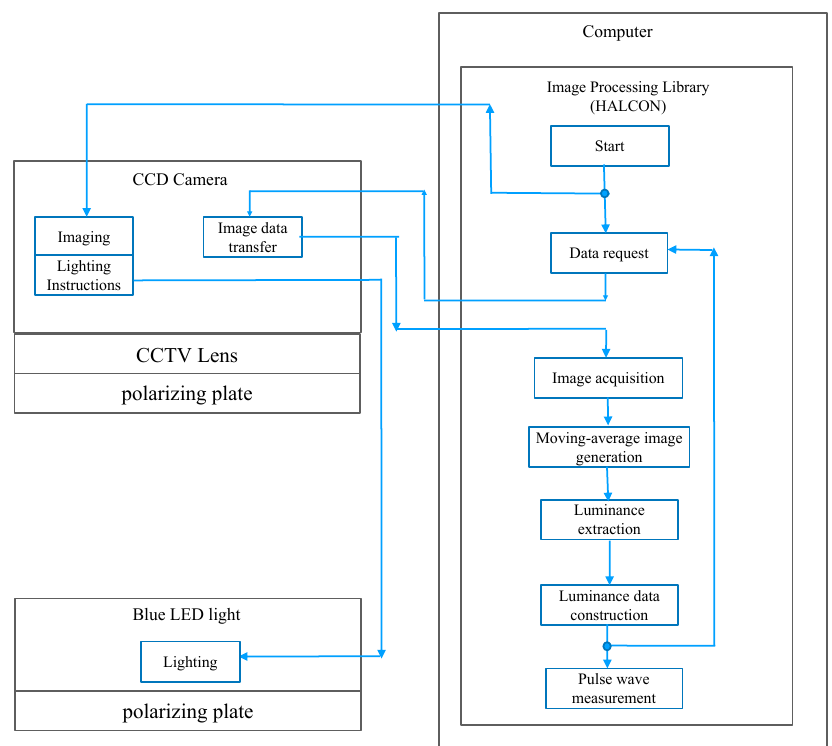
Figure 2. Experimental equipment. ( a ) External view of the experimental equipment. ( b ) Internal view of the light-shielding box.